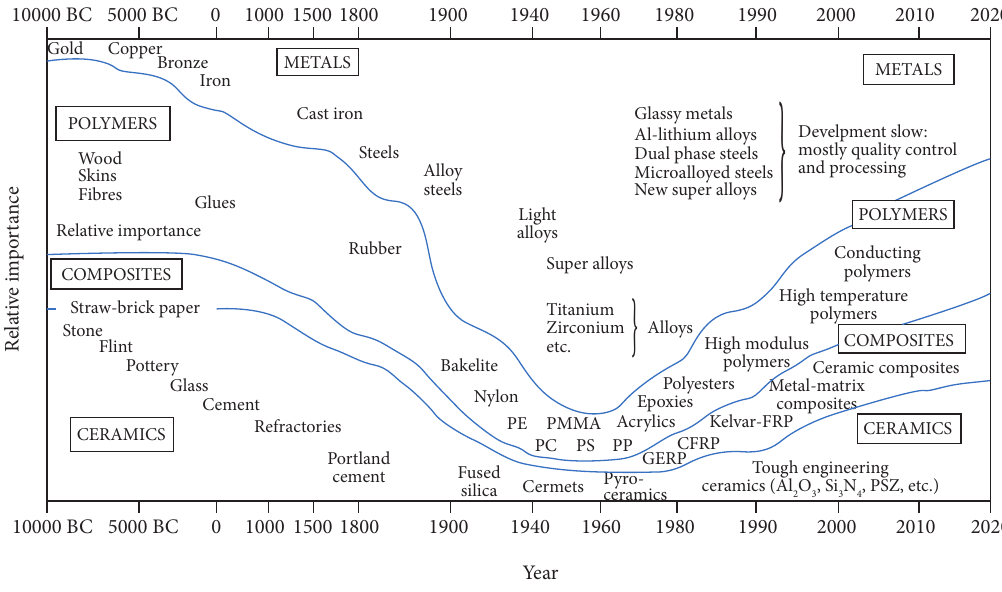
Figure 1. The importance of the four classes of materials (ceramics, composites, polymers, and metals) in engineering as a function of time. The timescale is nonlinear (White